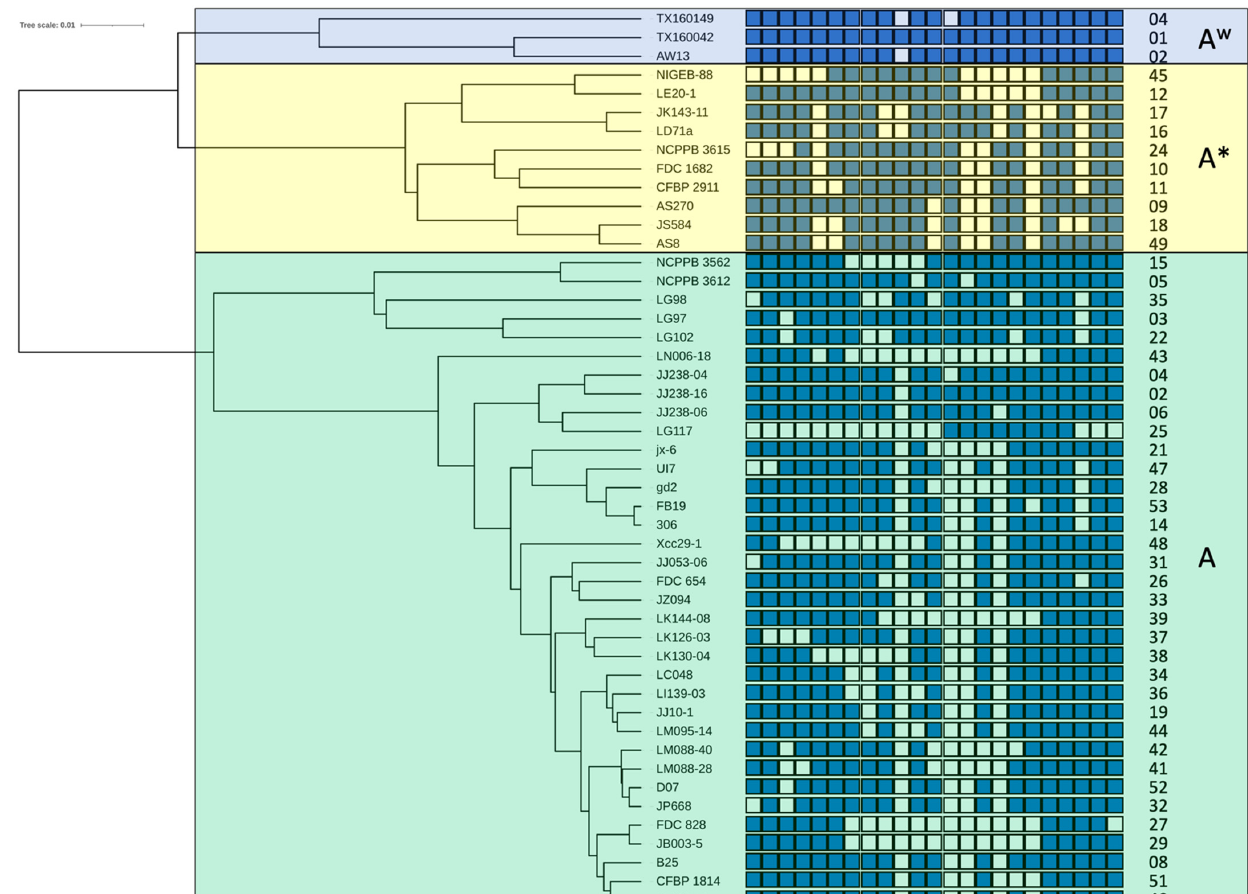
Figure 1. Phylogenetic tree of representative X. citri pv. citri strains and their associated spoligotypes. For each pathotype. i.e., A, A* and A w , one representative strain per spoligotype was included in the dataset to calculate genome-wide pairwise average nucleotide identities and perform their phylogenetic analysis on the enve-omics platform [21]. Complete (maximum) linkage clustering was used to build the phylogenetic tree [31]. The interactive Tree Of Life (iTOL) suite was used for better visualisation of the tree [32]. CRISPR arrays are represented by a series of 23 blue and open boxes, oriented with the leader-proximal spacers on the left side. Identical spacers within the same block are vertically aligned. Detected CRISPR spacers are represented by blue boxes. Open boxes indicate the absence of the corresponding spacer. Names of representative strains are shown between the tree and the CRISPR arrays. Spoligotype numbers are given on the right side. Transparent blue, yellow and green boxes frame pathotype-A w , pathotype-A*, and pathotype-A strains, respectively.